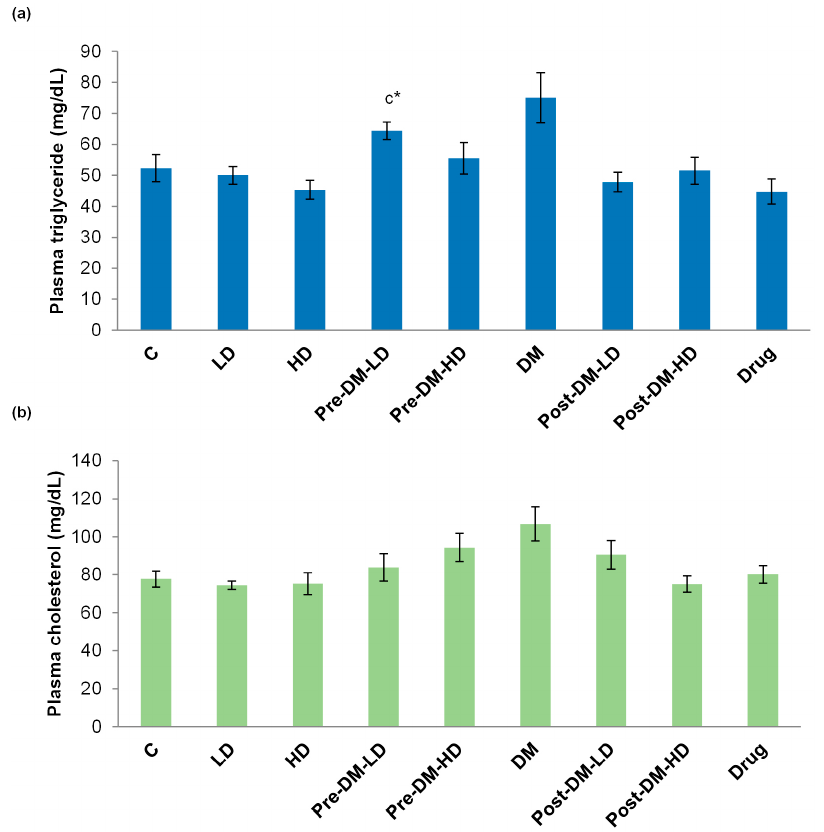
Figure 5. Effect of GBRE supplement on the ( a ) plasma triglyceride; and ( b ) cholesterol level in experimental rats. C: Control, LD: Low dose of GBRE to naïve rat, HD: High dose of GBRE to naïve rat, DM: Diabetes Mellitus induced rat, Pre-DM-LD: Low dose of GBRE to naïve rat and induced DM, Pre-DM-HD: High dose of GBRE to naïve rat and induced DM; Post-DM-LD: Low dose of GBRE to DM rat, Post-DM-HD: High dose of GBRE to DM rat. The significant difference between the groups (a = when compared with control group; b = when compared with DM group; c = when compared with the drug group) were represented as * ( p < 0.05).